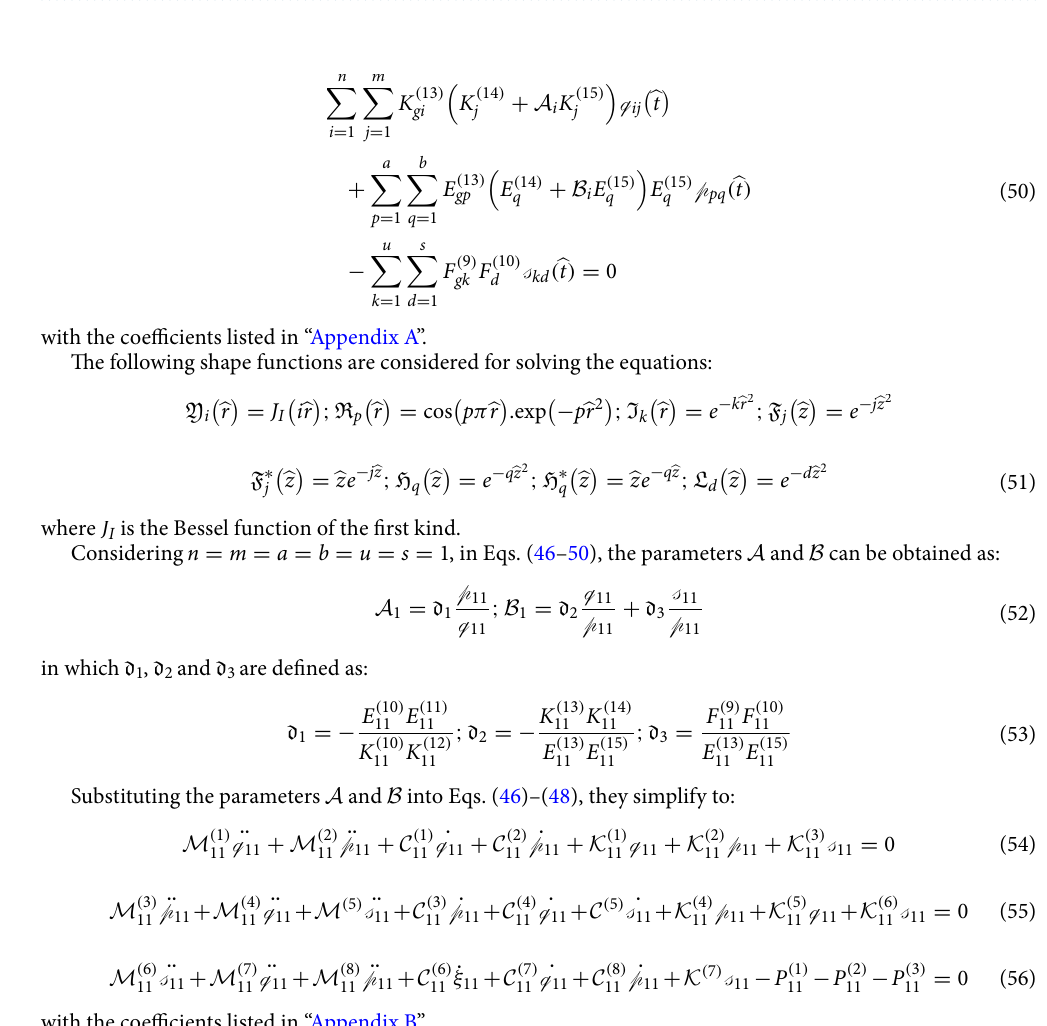
Table 1. Properties of the skin tissue and the laser heat source 25,45